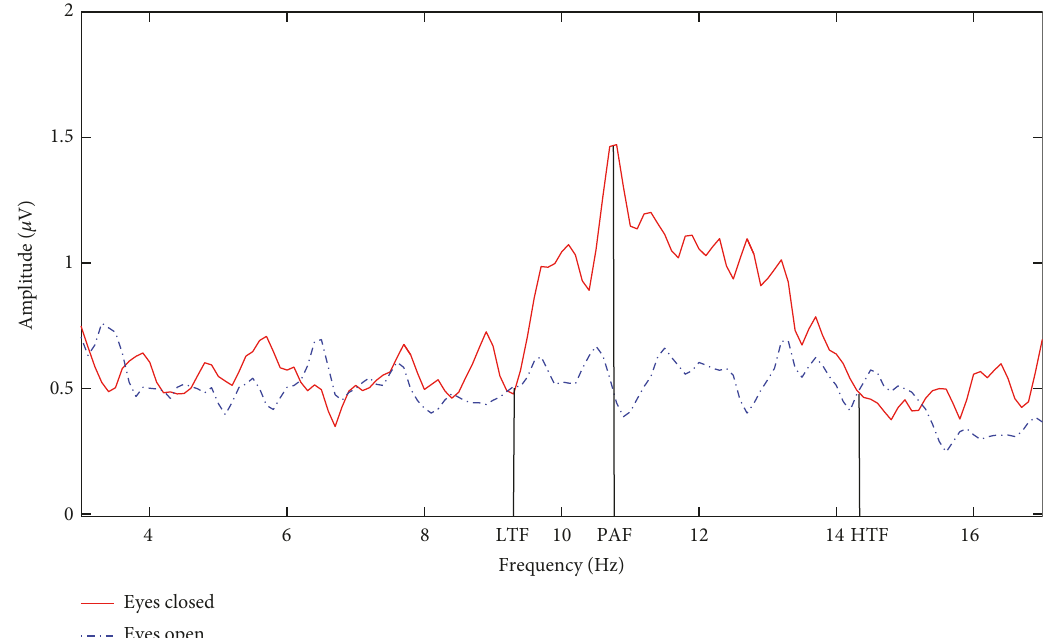
Figure 1: The illustration of determining the